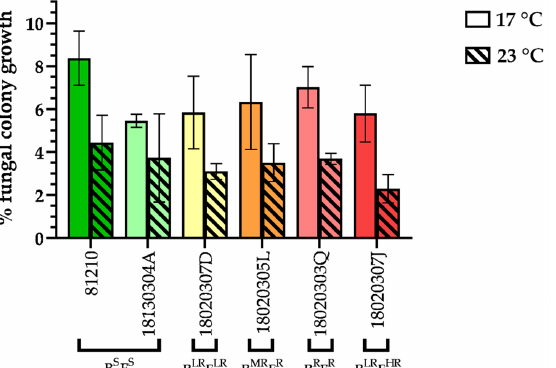
Figure 3. Percentage of fungal colony growth, starting from a single spore and covering the surface of a zucchini cotyledon. P. xanthii isolates with different SDHI phenotypes (sensitive (S) and